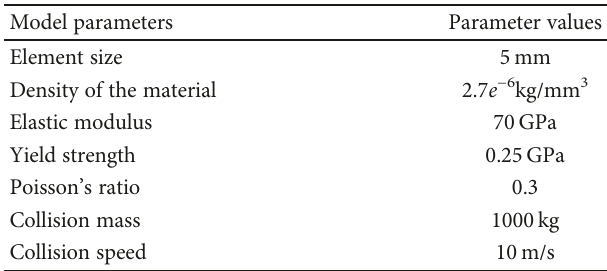
Figure 11: Simpli fi ed engineering design of the bionic rib according to the structure of the bamboo node. Table 3: Finite-element model